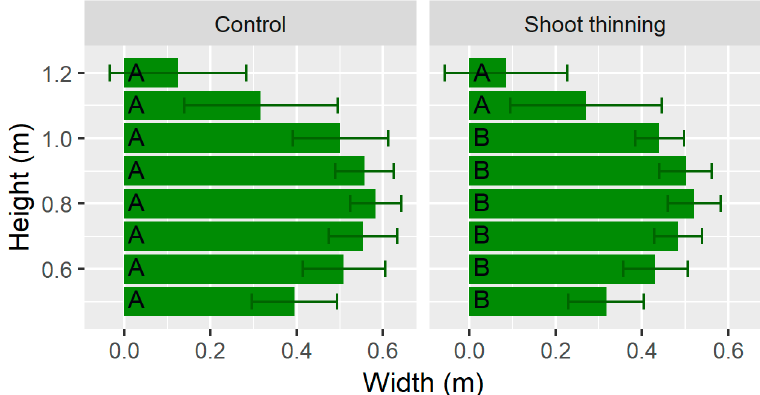
Figure 7. Vine width at different heights after the shoot thinning experiment at Azagra (error bars represent the standard deviation). For each height, different letters indicate significant differences among treatments at p = 0.05 by a Student’s T-test.